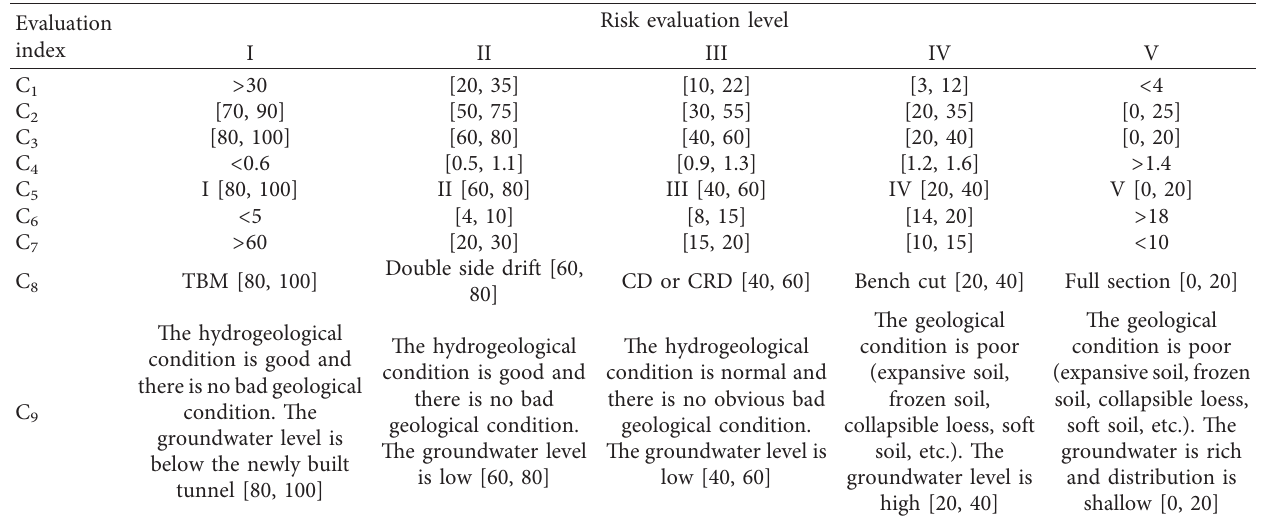
Figure 2: The risk evaluation index system of the existing tunnel in a tunneling construction Table 1: Classification of risk level for assessment index.